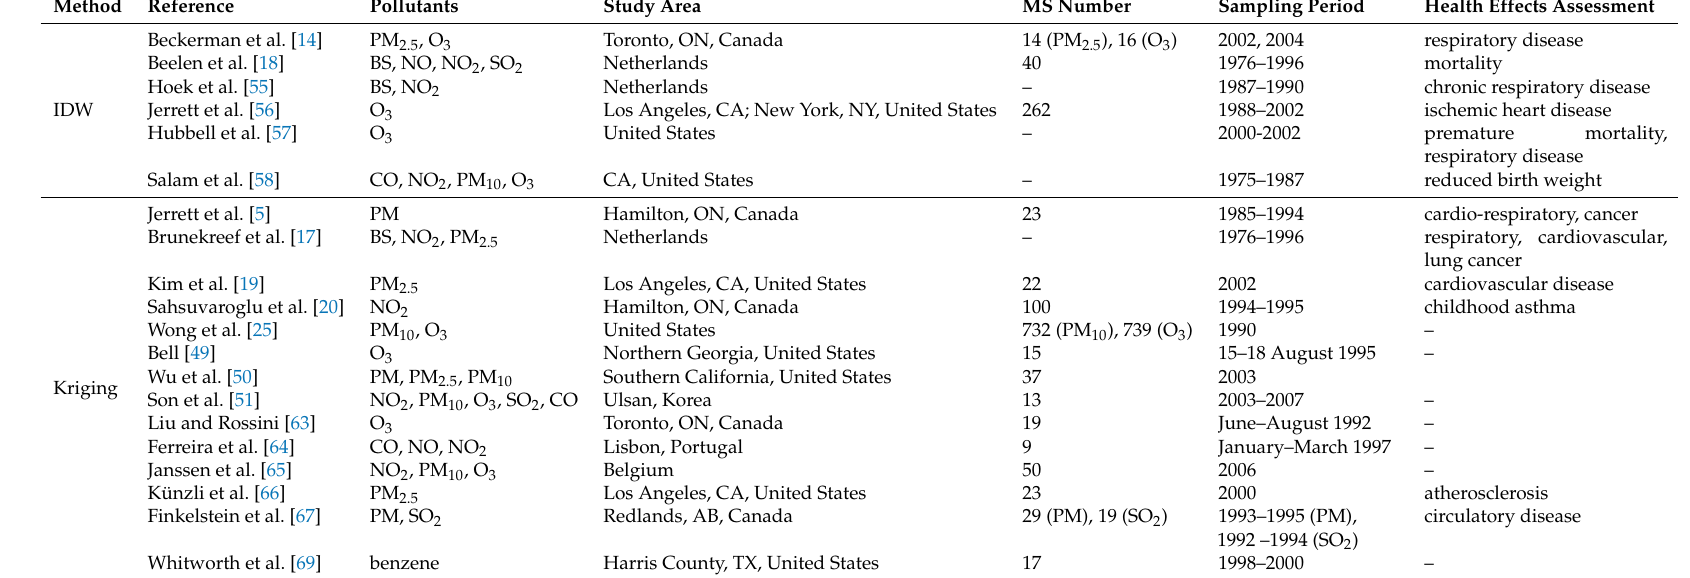
Table 1. Spatial interpolation